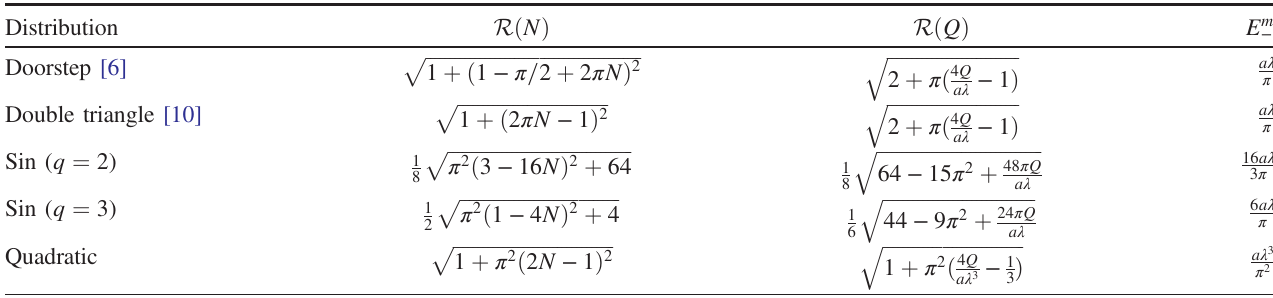
TABLE I. Table comparing several different proposed drive bunch distributions as a function of bunch length and charge. Additionally, the maximum decelerating field ( E m − ) is shown for each distribution. Here we consider κ ¼ 1 . Distribution